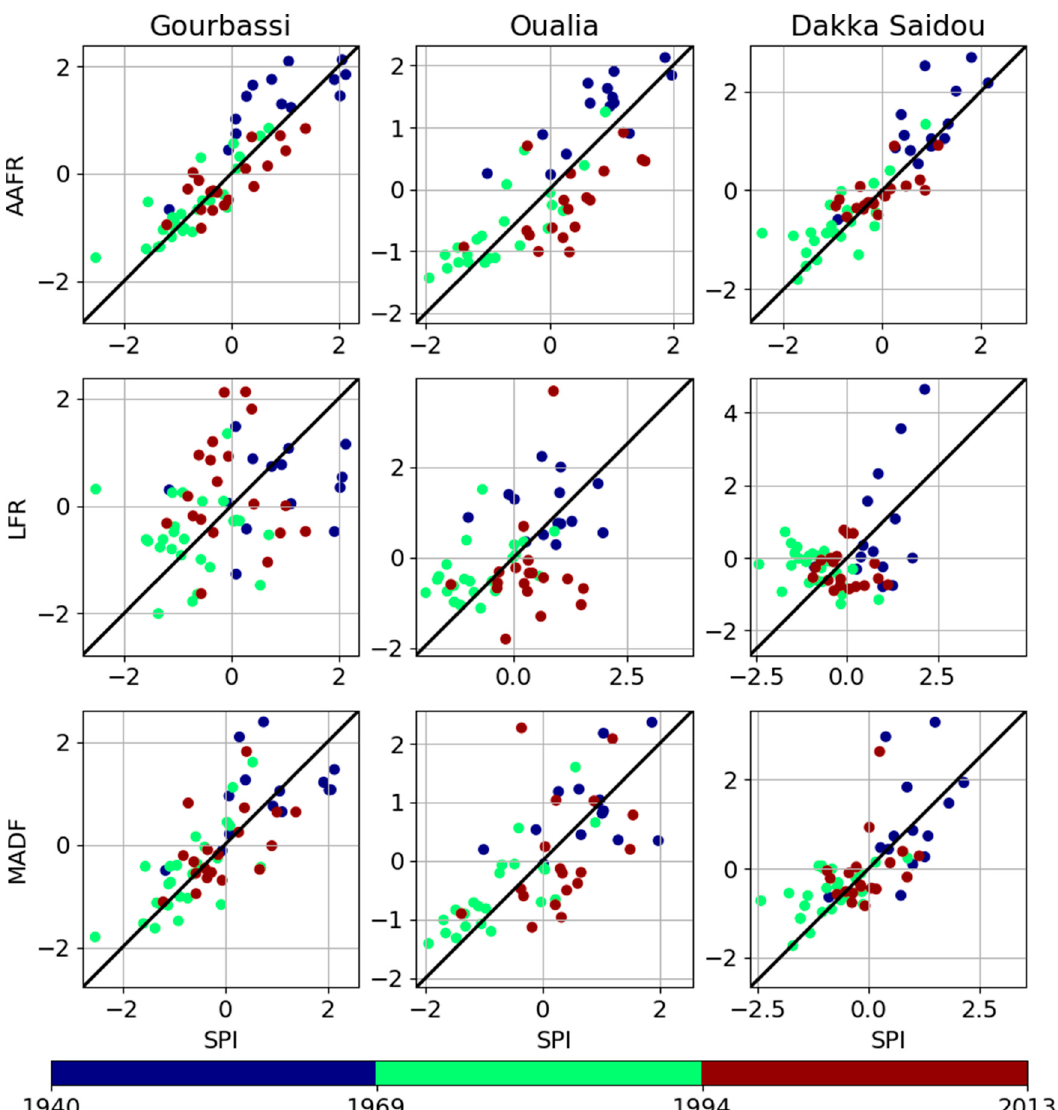
Figure 7. Relationship between SPIs and hydrological variables.